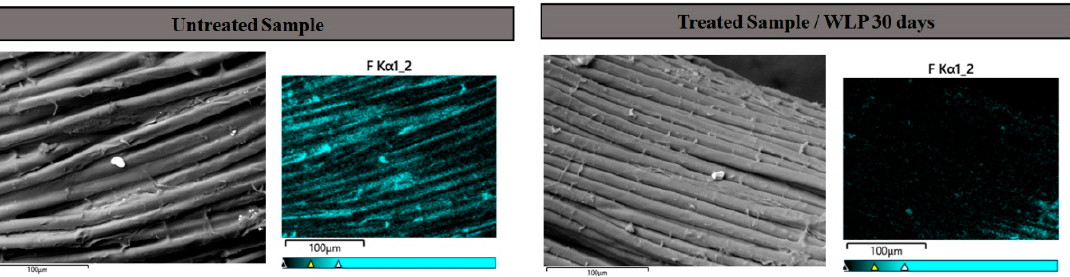
Figure 8. Compositional maps for fluorine for the untreated sample and for the treated sample with WLP and 0% H 2 O 2 for 30 days.